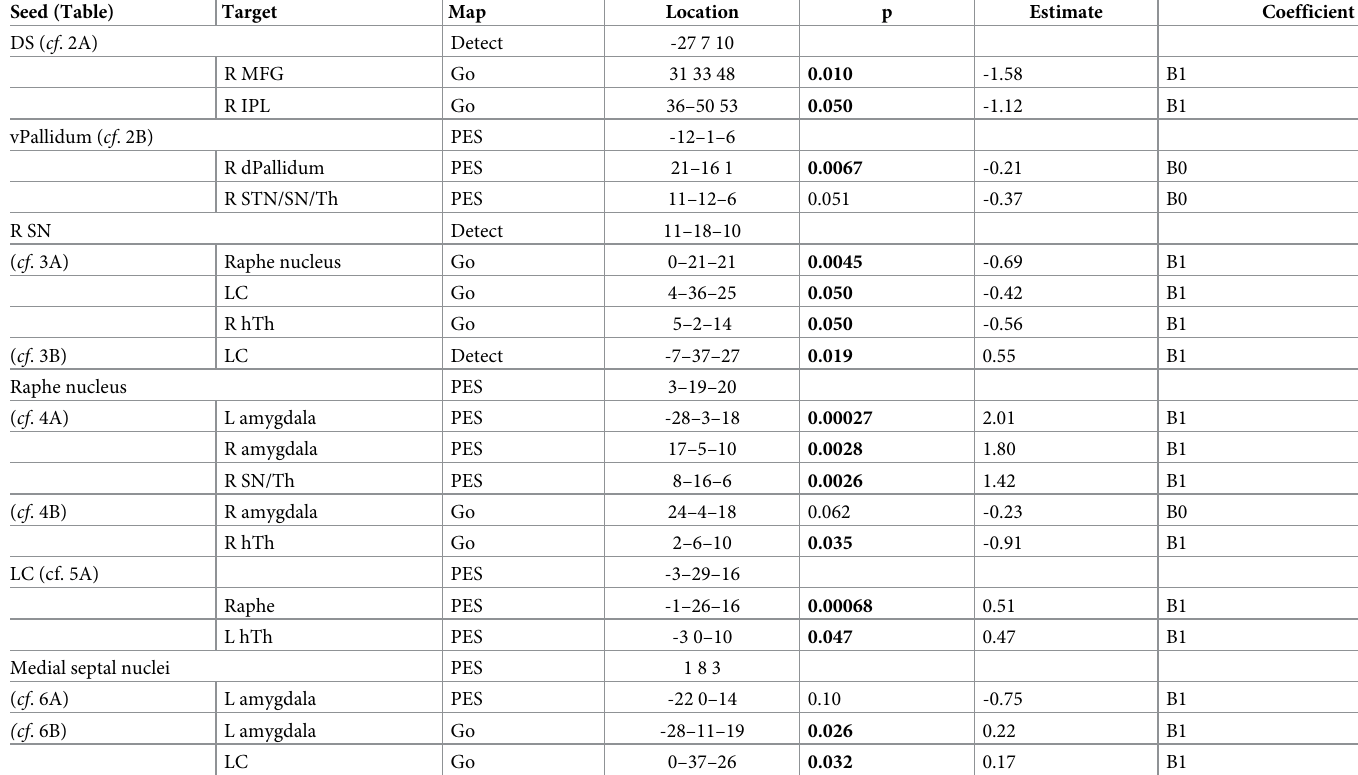
Table 7. Replication of correlations from TD in healthy